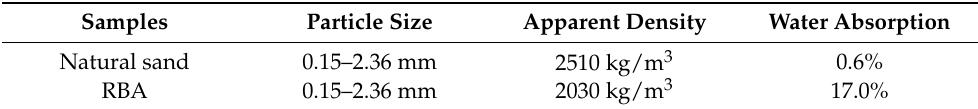
Table 1. Properties of natural sand and recycled brick aggregate (RBA).